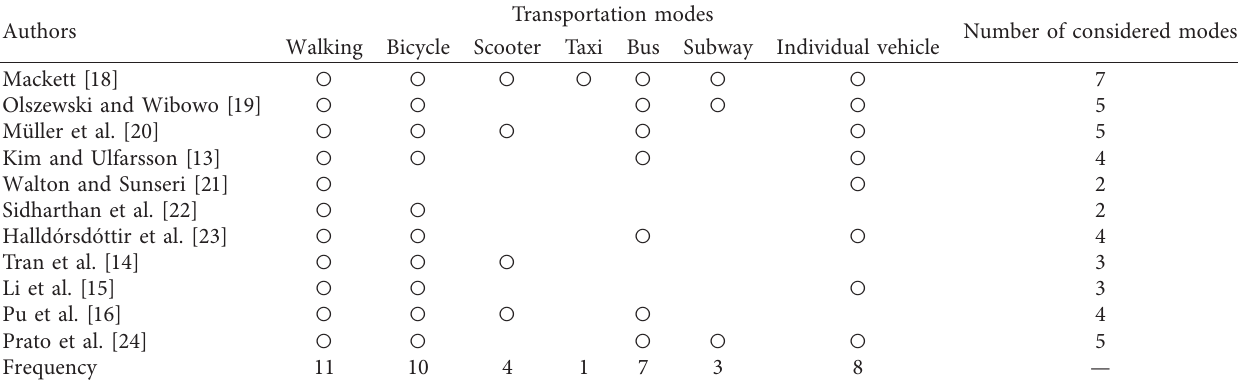
Table 2: Comparison of transportation modes considered regarding a short-distance